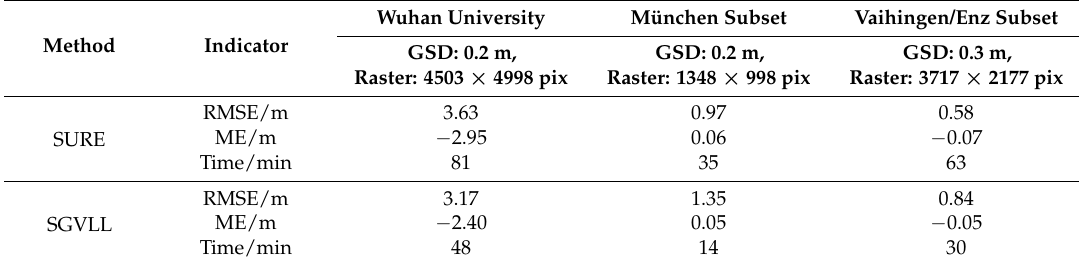
Table 1. Quantitative Evaluation (RMSE, ME, and Time Consumption) of SURE and SGVLL.